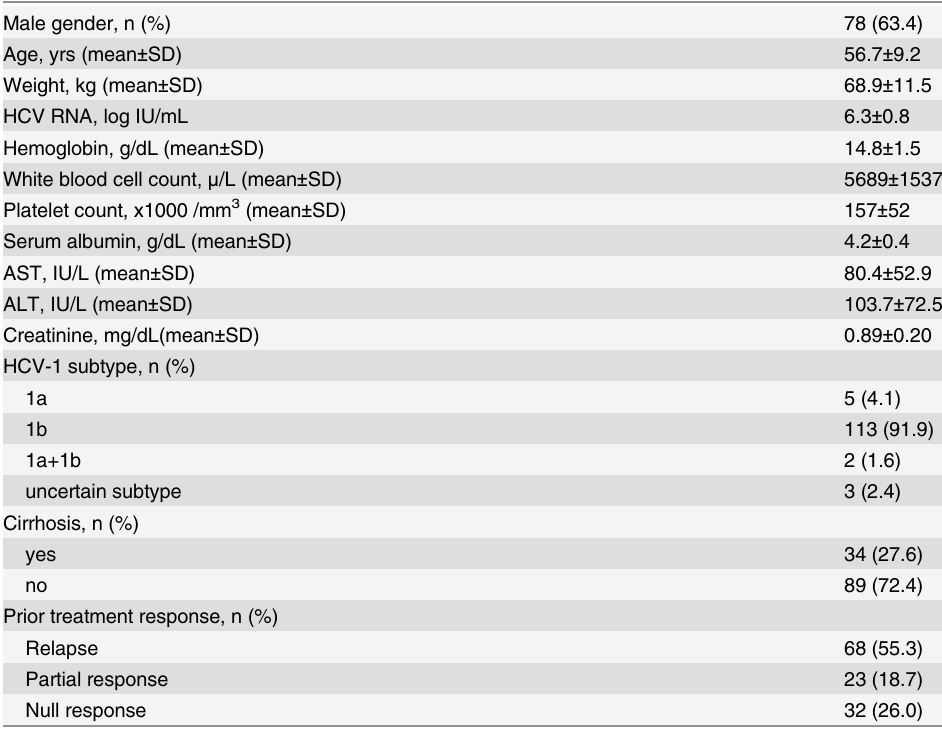
Table 1. Characteristics of 123 chronic hepatitis C patients who failed previous interferon-based ther- apy. Abbreviations: HCV, hepatitis C virus; AST, aspartate aminotransferase; ALT, alanine